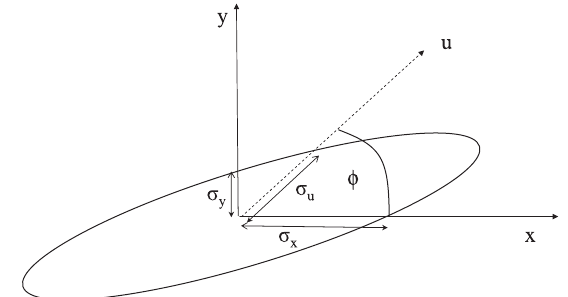
FIG. 10. Bunch with horizontal-vertical coupling, such that its major axis does not lie along the horizontal. In addition to vertical and horizontal scans, a scan of the u -axis is necessary, where u is at an angle (cid:12) to the vertical as